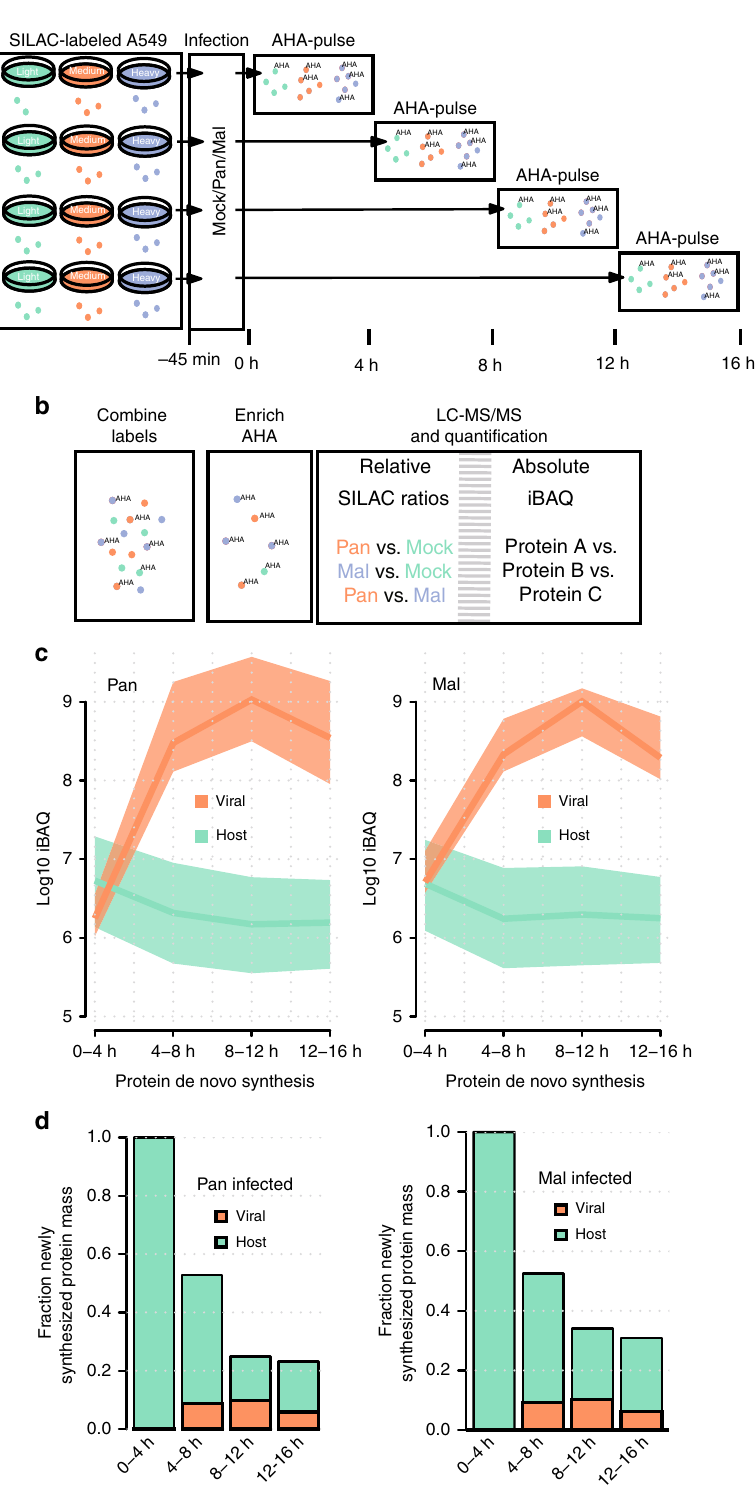
Fig. 1 A strategy to quantify protein de novo synthesis proteome-wide. a SILAC-L/M/H-labeled A549 cells were infected with the human seasonal H3N2 IAV isolate Panama (Pan) or the avian H3N2 isolate Mallard (Mal) or left uninfected. The methionine analogous AHA was given to the methionine- depleted medium in different 4 h intervals. b After lysis and enrichment for proteins that incorporated AHA, samples were subjected to shotgun proteomics. Absolute and relative protein synthesis pro fi les were quanti fi ed for host and viral proteins. c iBAQ-based quanti fi cation of protein synthesis levels for host and viral proteins in cells infected with either Pan or Mal virus, as indicated. Median, 25th and 75th percentile of the respective populations are given. d Quanti fi cation of the total newly synthesized protein mass for host and viral proteins with either Pan or Mal infection as indicated. Data were normalized to the 0 – 4 h time period. All data are based on the mean of n = 2 biological